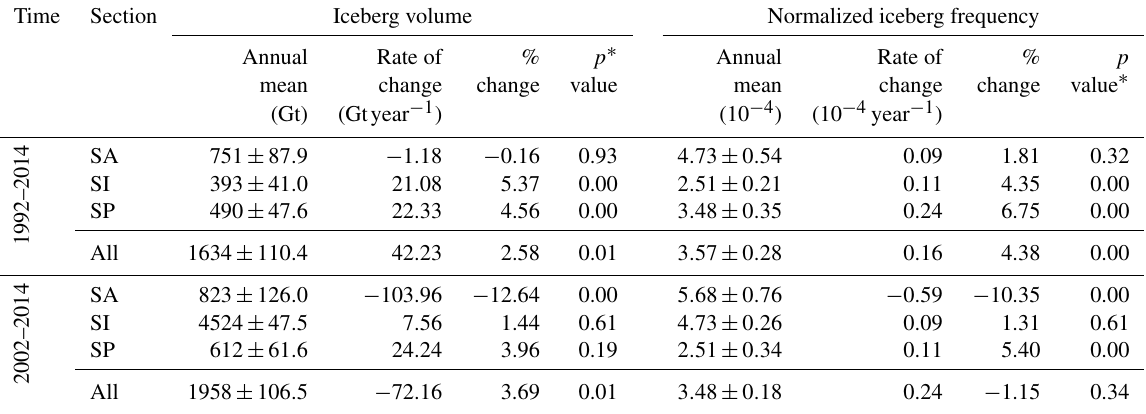
Table 7. Temporal trend of annual volume and frequency of small icebergs by sections of the SO. Time Section